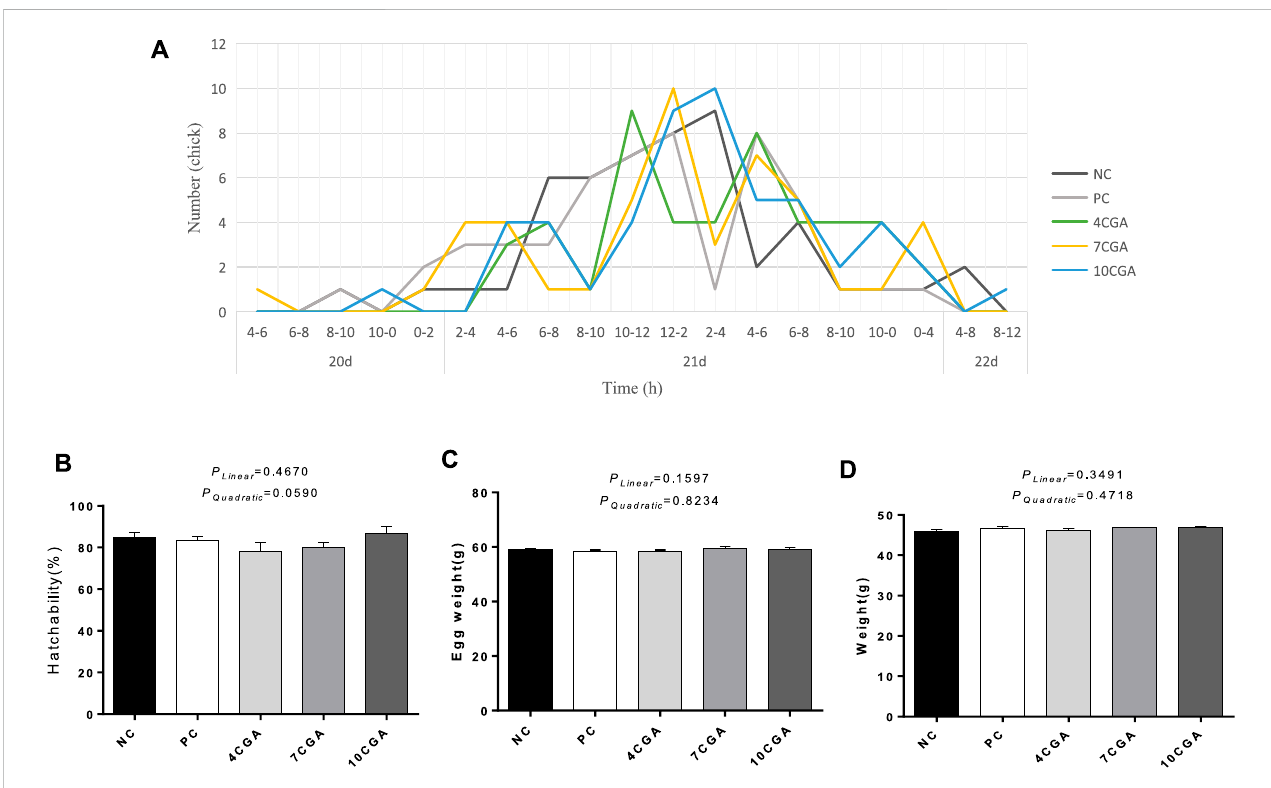
FIGURE 1 Effects of in ovo feeding of chlorogenic acid on hatching performance of broilers. (A) Hatching time; (B) Hatchability, n = 6; (C) Egg weight at hatching, n = 6; (D) Body weight of hatching broilers, n = 6.